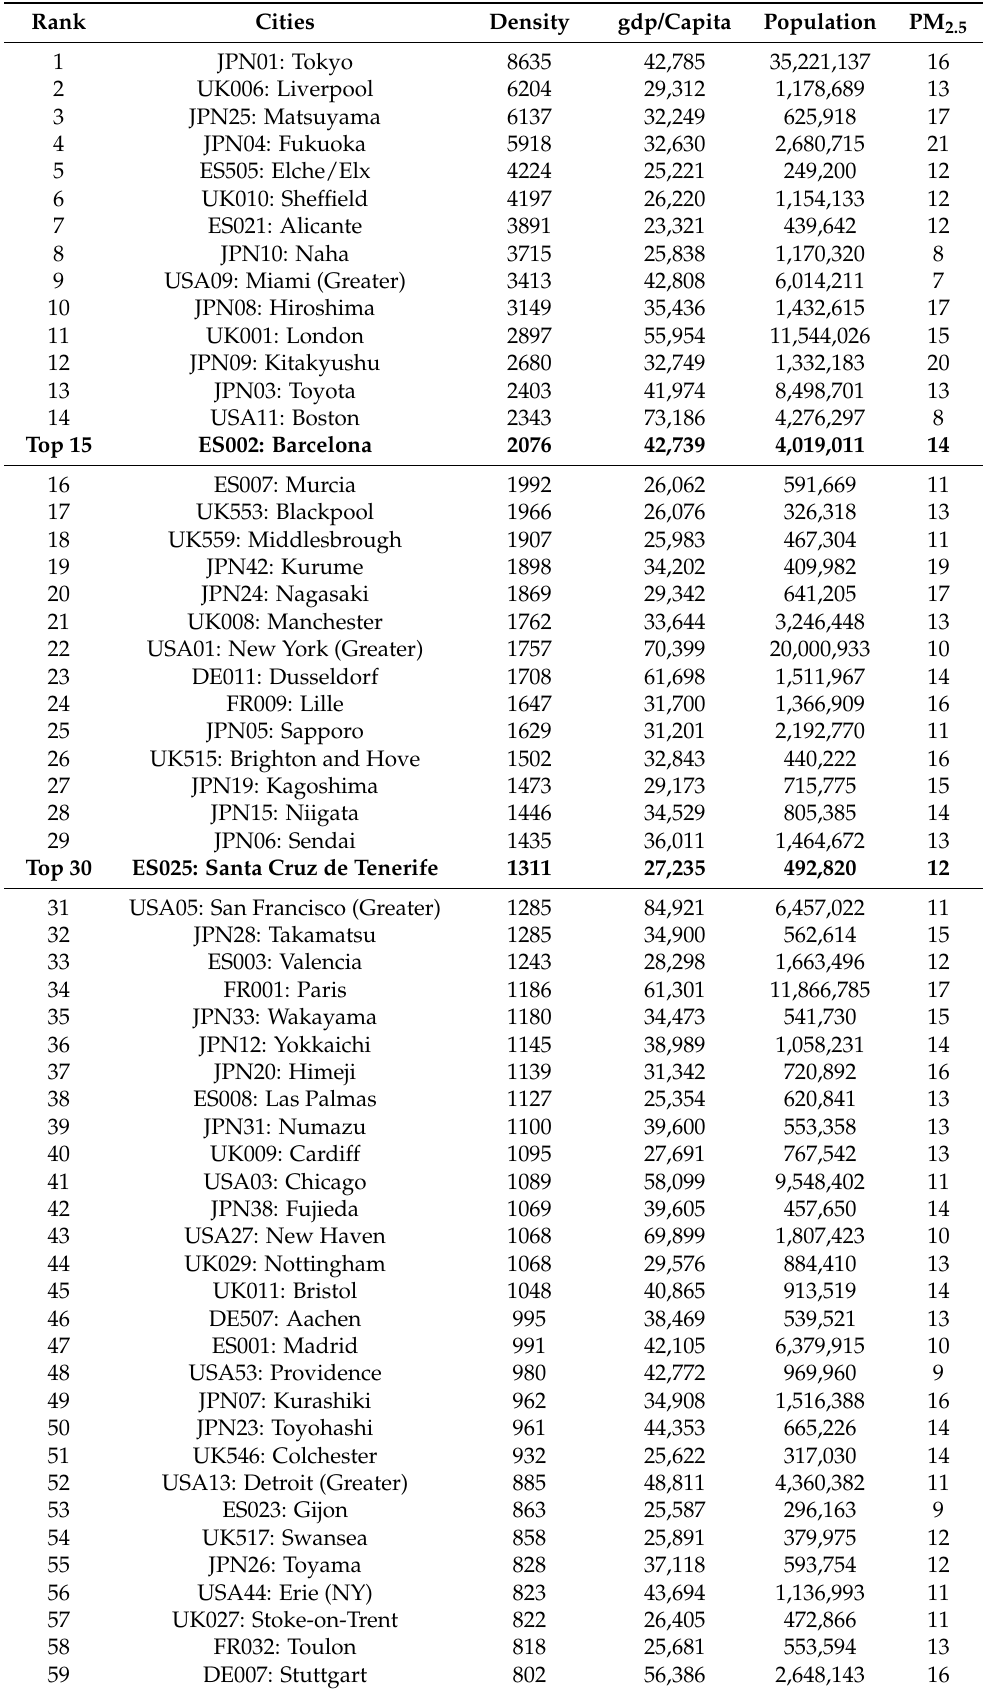
Table A2. Ranking of 254 cities into 5 subgroups by population